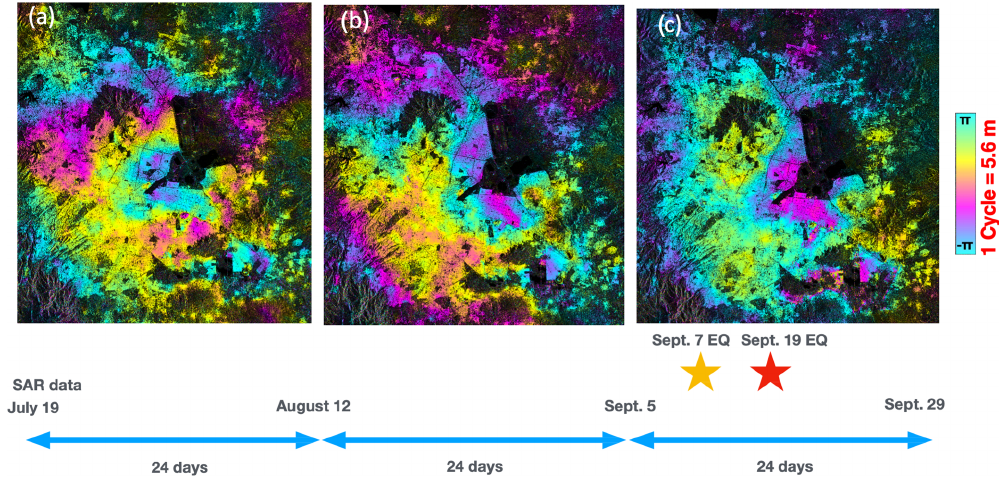
Figure 3. Sentinel-1 based wrapped differential interferograms for the Mexico City Metropolitan Area covering (a) 19 July–12 August 2017, (b) 12 August–5 September 2017, and (c) 5–29 September 2017. Color lookup table for all interferograms depicts 1 cycle =